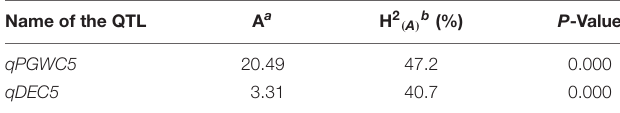
Frontiers in Plant Science |